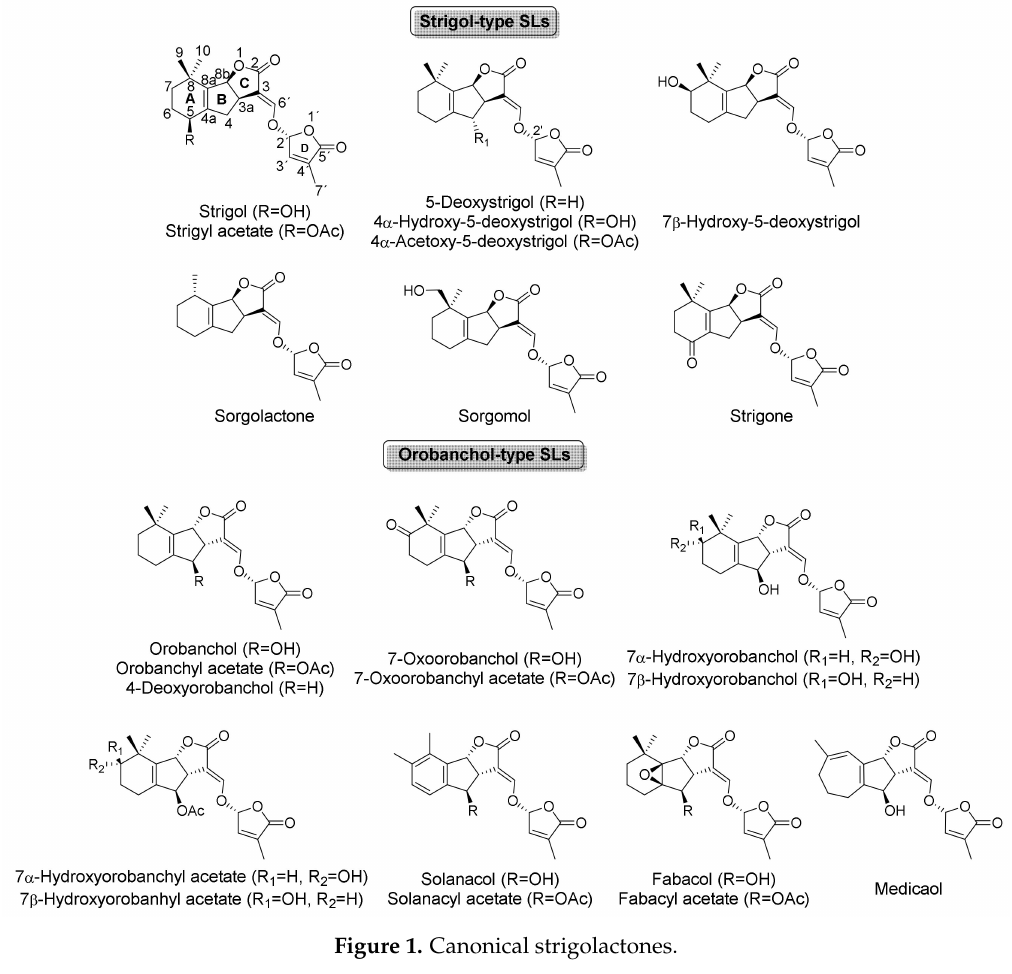
Figure 1. Canonical strigolactones.